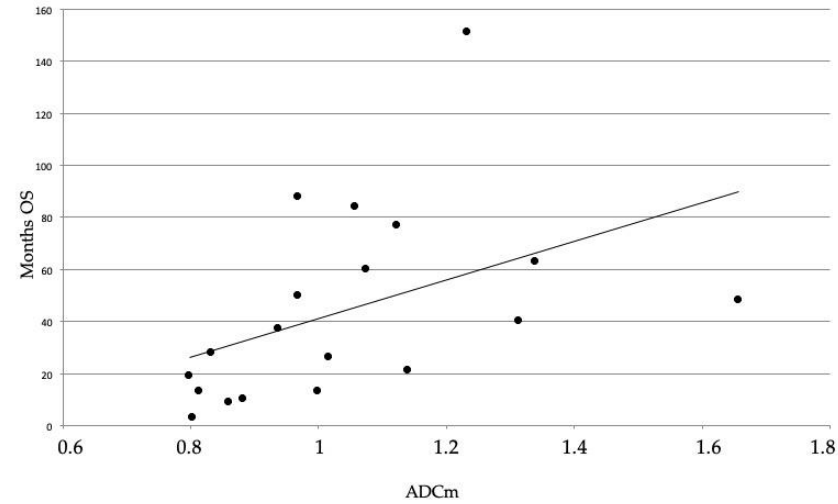
Figure 6. Spearman’s rho correlation between the ADCm values and overall survival of twenty patients showing a positive relationship between the variables ( p = 0.003; r = 0.62), making the ADCm a biomarker predictor of the OS.